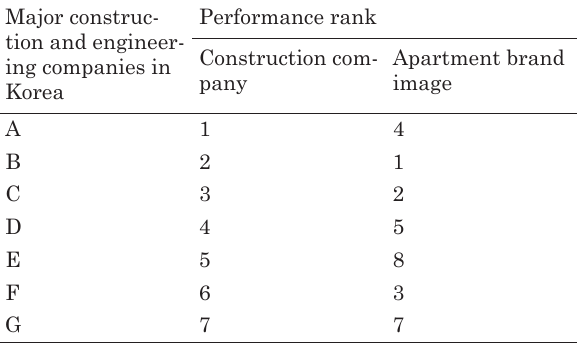
Table 4. Performances of major